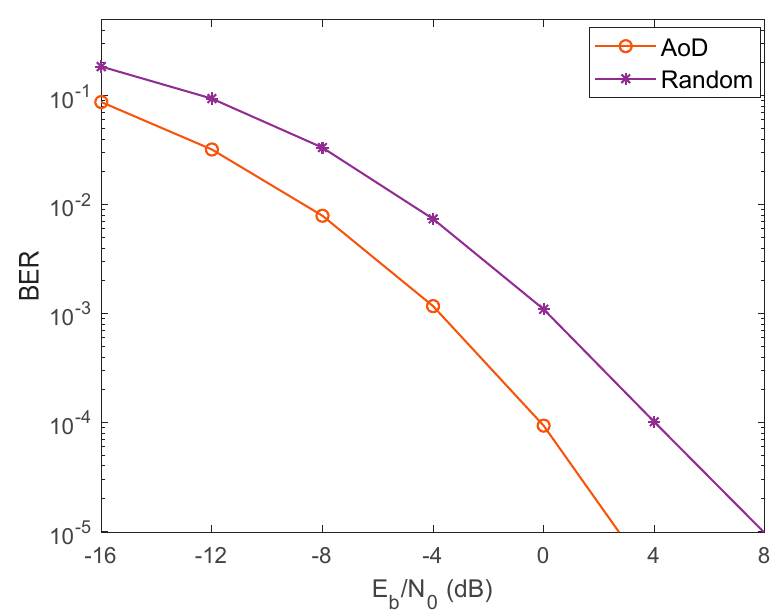
Figure 4. Performance comparison of the proposed hybrid AoD- and random-based precoder, for N tx = 8 and N rx = 32 when N RF rx = 8. BER, bit error rate.